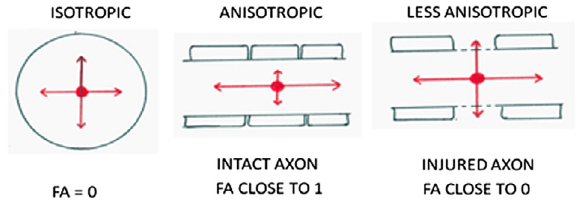
Figure 1. Isotropic and anisotropic diffusion of water